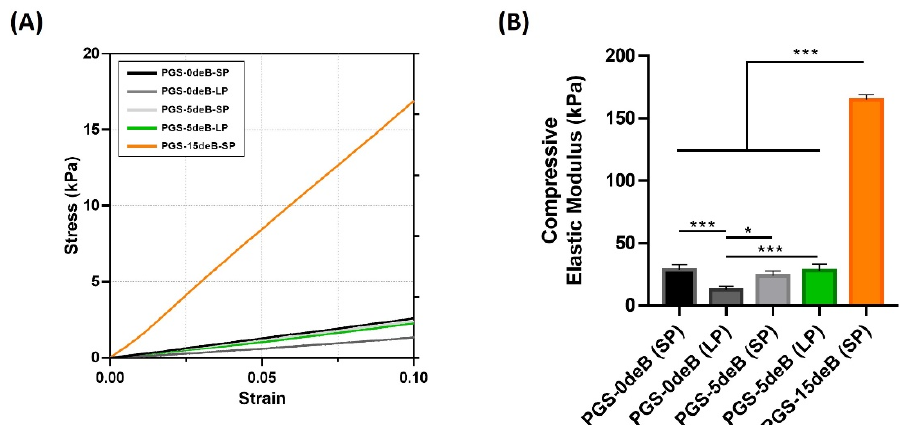
Figure 8. The effects of deB incorporation and pore size on the mechanical properties of the PGS-deB blend scaffolds and bone-free porous PGS-0deB-SP and PGS-0deB-LP; stress-strain curve ( A ) and compressive modulus; * p < 0.05 and *** p ≤ 0.001 indicates statistical significance ( B ).